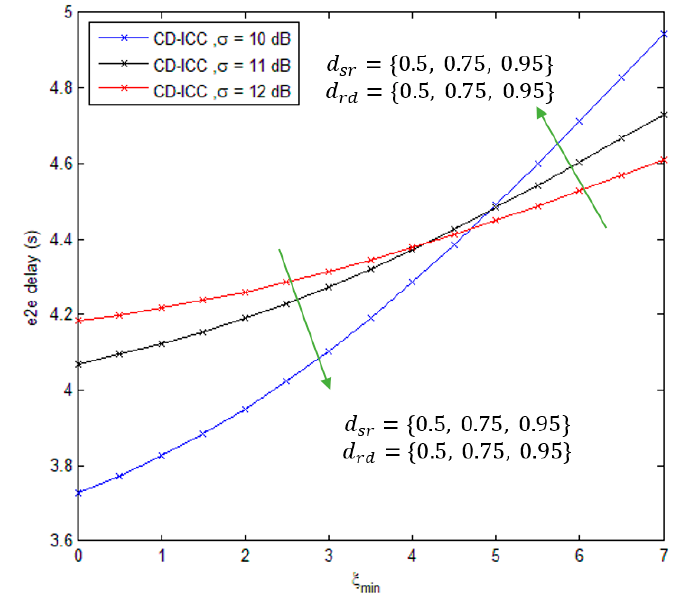
Figure 6. e2e delay of CD-ICC with 𝜉 (cid:3040)(cid:3036)(cid:3041) . In all cases, 𝑑 (cid:3046)(cid:3031) is 1 and 𝜌 is 3.5.